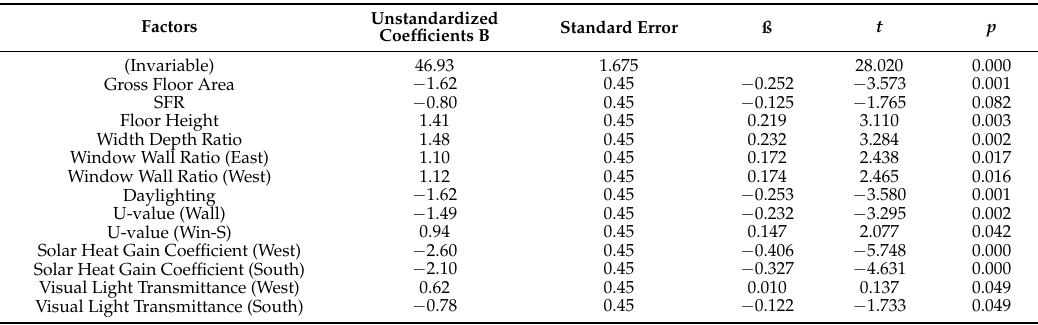
Table 5. Coefficient (a) for Cooling